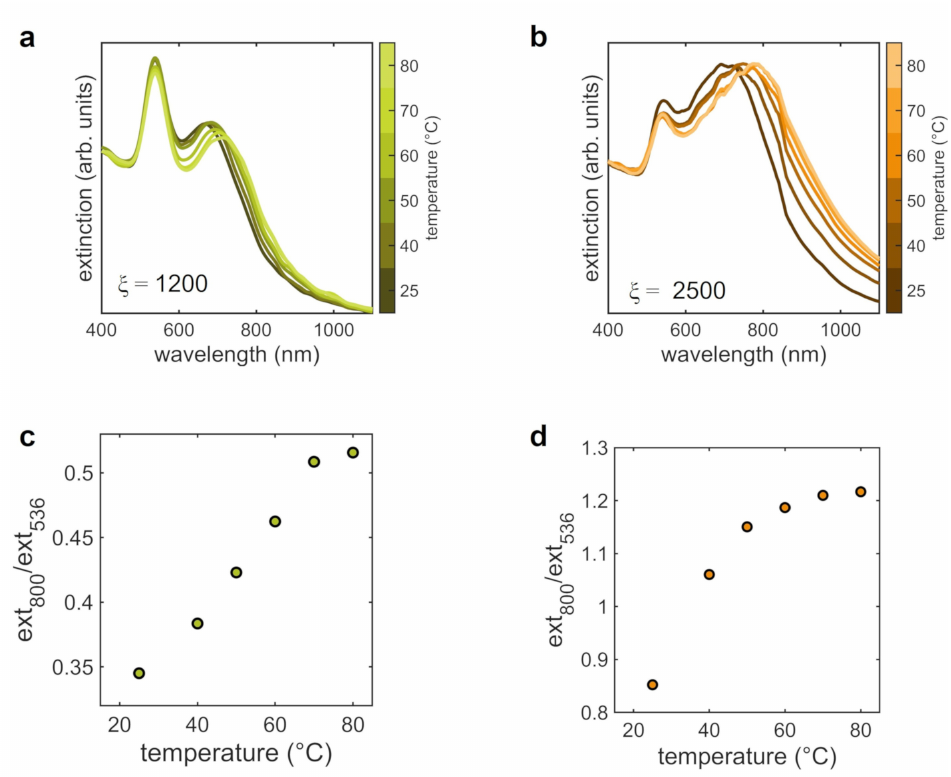
Figure 7. Optical properties of AuNPs clusters at varying the temperature of the solution for the two lysozyme-AuNPs number ratios analyzed, ξ = 1200 and ξ = 2500. ( a , b ) Extinction spectra at varying temperature; ( c , d ) calibration curves as a function of temperature, derived from the extinction spectra by the ratio between the extinction values at 800 and 536 nm. The pH of the solutions was 6.5 during